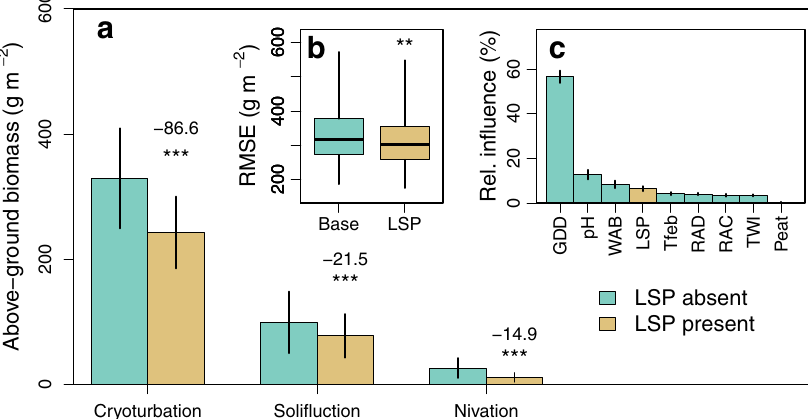
Fig. 2 The effect of cryogenic land surface processes (LSP) in the biomass models. a The bar plots show the effect sizes of the observed LSP on estimated AGB after controlling for the effects of other environmental predictors. The lines indicate 95% con fi dence intervals based on boosted regression trees (BRT) modeling over 500 bootstrap samples. Asterisks indicate statistically signi fi cant differences between sites with LSP absent and LSP present ( P ≤ 0.001, paired one-sided t-test, n = 500). b Prediction error of the AGB models in terms of root mean squared error (RMSE) between observations and each of the model predictions (calibrated fi rst without LSP [Base model] and then with LSP [LSP model]). The boxplots depict median, 1 st and 3 rd quartiles, and 95% range of variation over 500 cross-validation rounds. Asterisks indicate statistically signi fi cant model improvement ( P ≤ 0.01, paired one-sided t -test, n = 500). c Predictors ’ relative in fl uence in the above-ground biomass (AGB) models. Here, the LSP includes the summed in fl uences of cryoturbation, soli fl uction and nivation (numerical results are presented in Supplementary Table 2). The black lines indicate the standard deviation over 500 BRT model runs with bootstrap sampling. GDD growing degree days, WAB water balance, Tfeb February mean air temperature, RAD potential incoming solar radiation, RAC residual autocovariate for the LSP model (i.e., RAC LSP ), TWI topographic wetness index, Peat peat